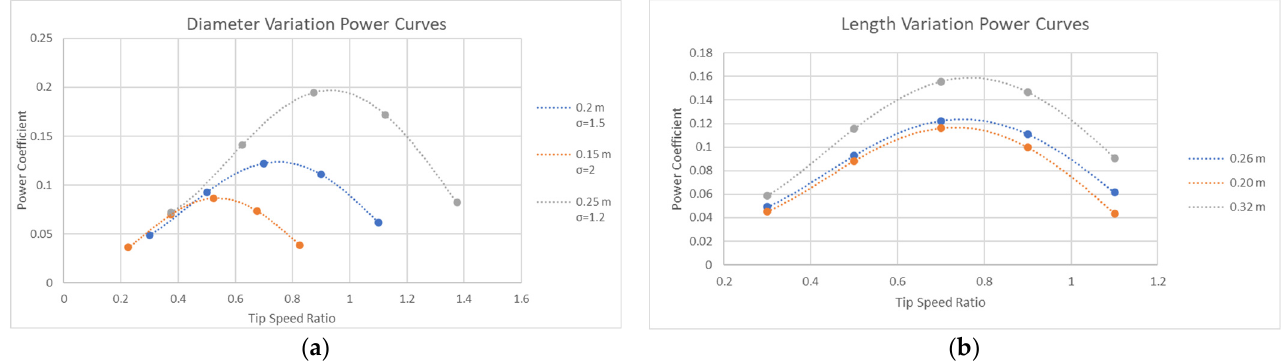
Figure 12. Power curves for variation of: ( a ) Diameter; ( b ) Blade length/height.